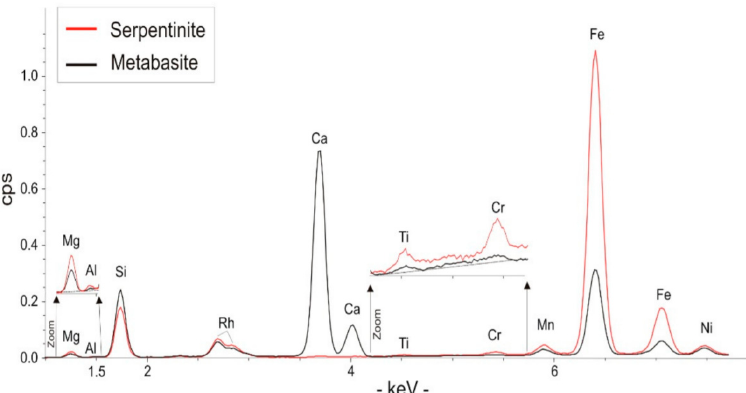
Figure 6. Portable XRF spectra of serpentinite and metabasaltic rocks, reproduced from [71]. Table 2. Limits of detection (LOD) for some important elements (in µg/g) across the periodic table by portable XRF [72].